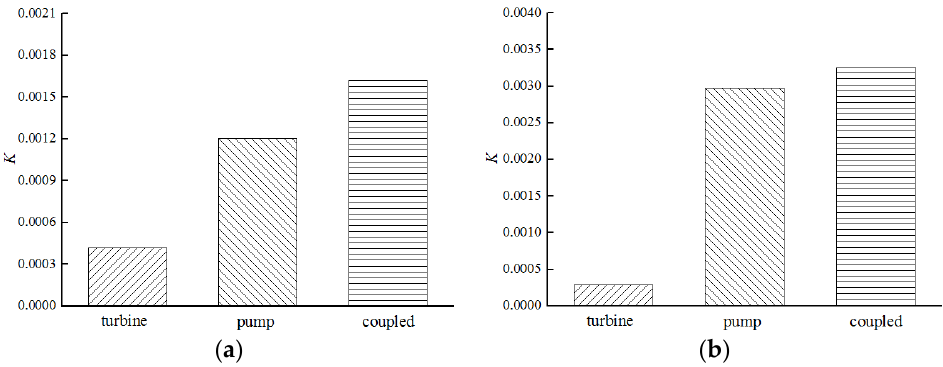
Figure 19. Force amplitude at the frequency of 15 f R . ( a ) Impeller. ( b ) Housing.